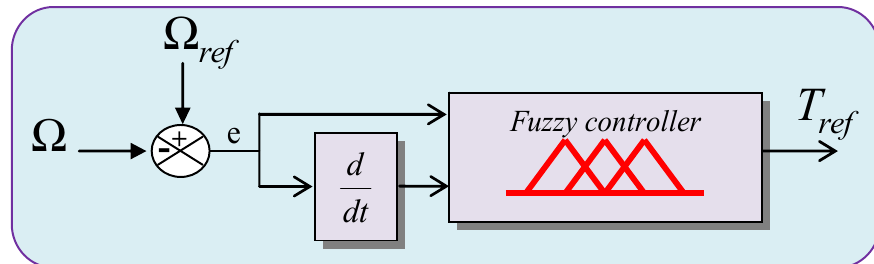
Figure 9. Fuzzy speed controller.